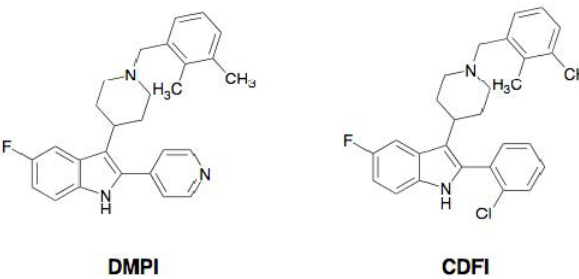
Figure 7. Structures of DMPI and CDFI.